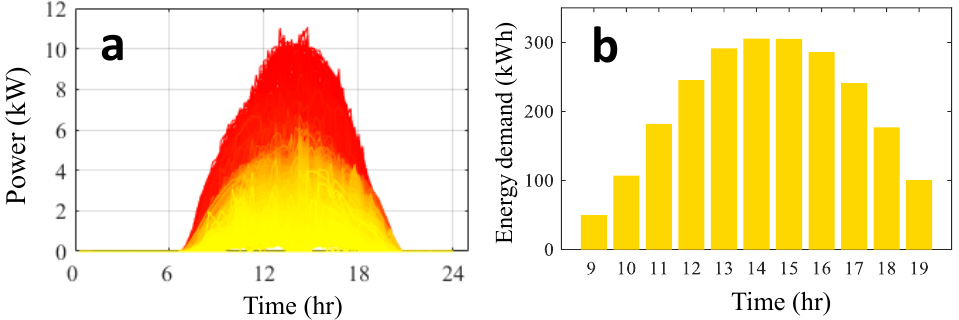
Figure 3. Solar generation patterns in the case-study community: ( a ) PV power profiles, ( b ) daily averaged PV-generated energy.